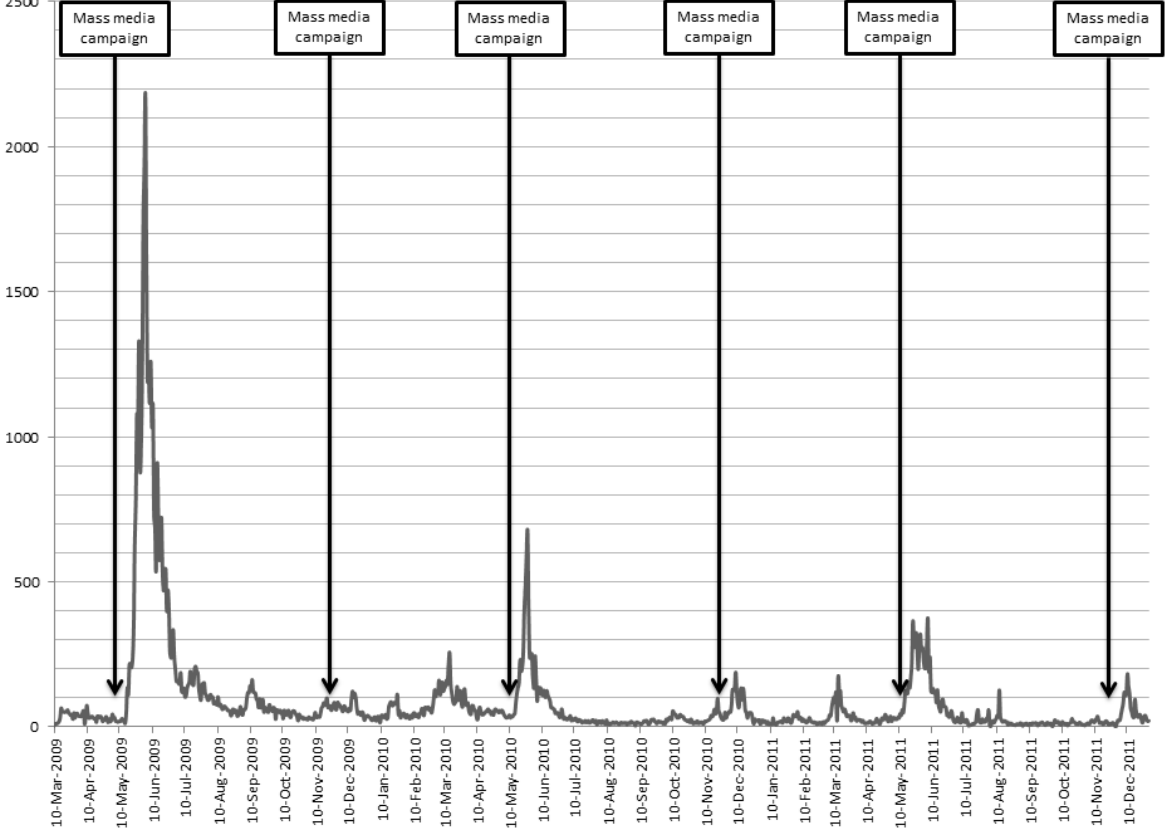
Figure 1. Participant enrollment per month in the NutriNet-Santé Study from March 2009 to December 2011 in relation to mass media campaigns